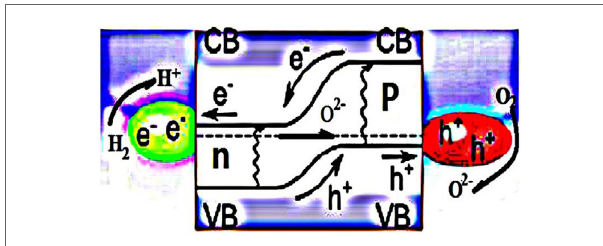
FiGURe 7 | eFFC built on the BHJ structure and working principle . [Permission from Zhu et al. (2013a). Available from: http://www.sciencedirect.